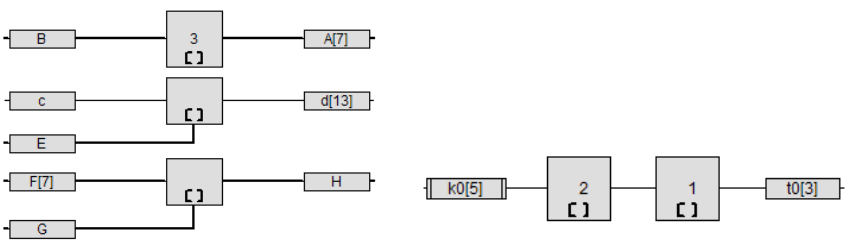
Figure 8. Examples of use of array subscripting: B = A [3]; c = d [E]; F [G] = H; K [2] = t0 [1].